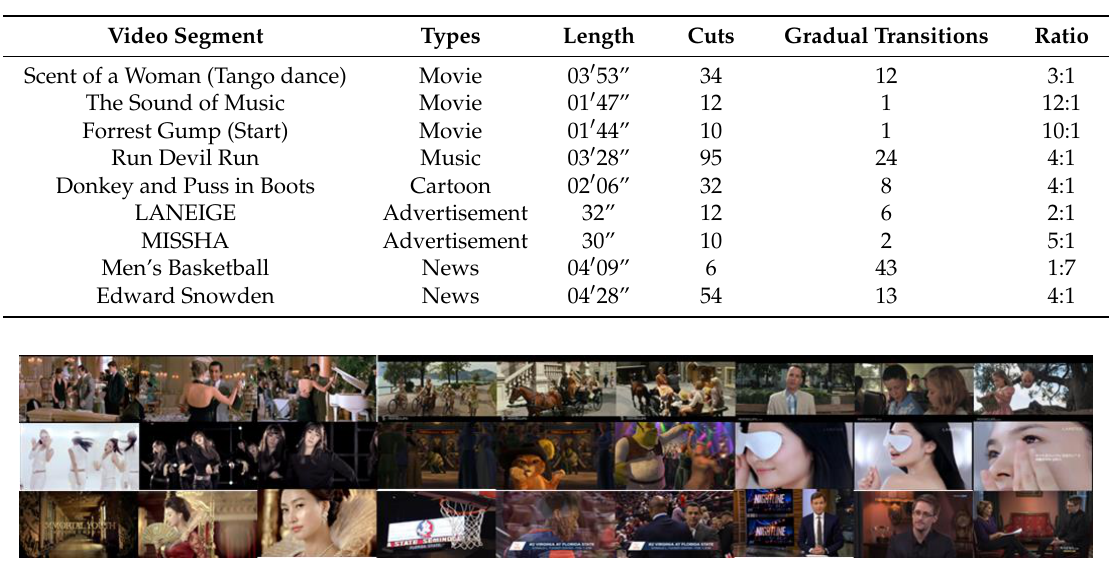
Table 5. The training videos for threshold selections.